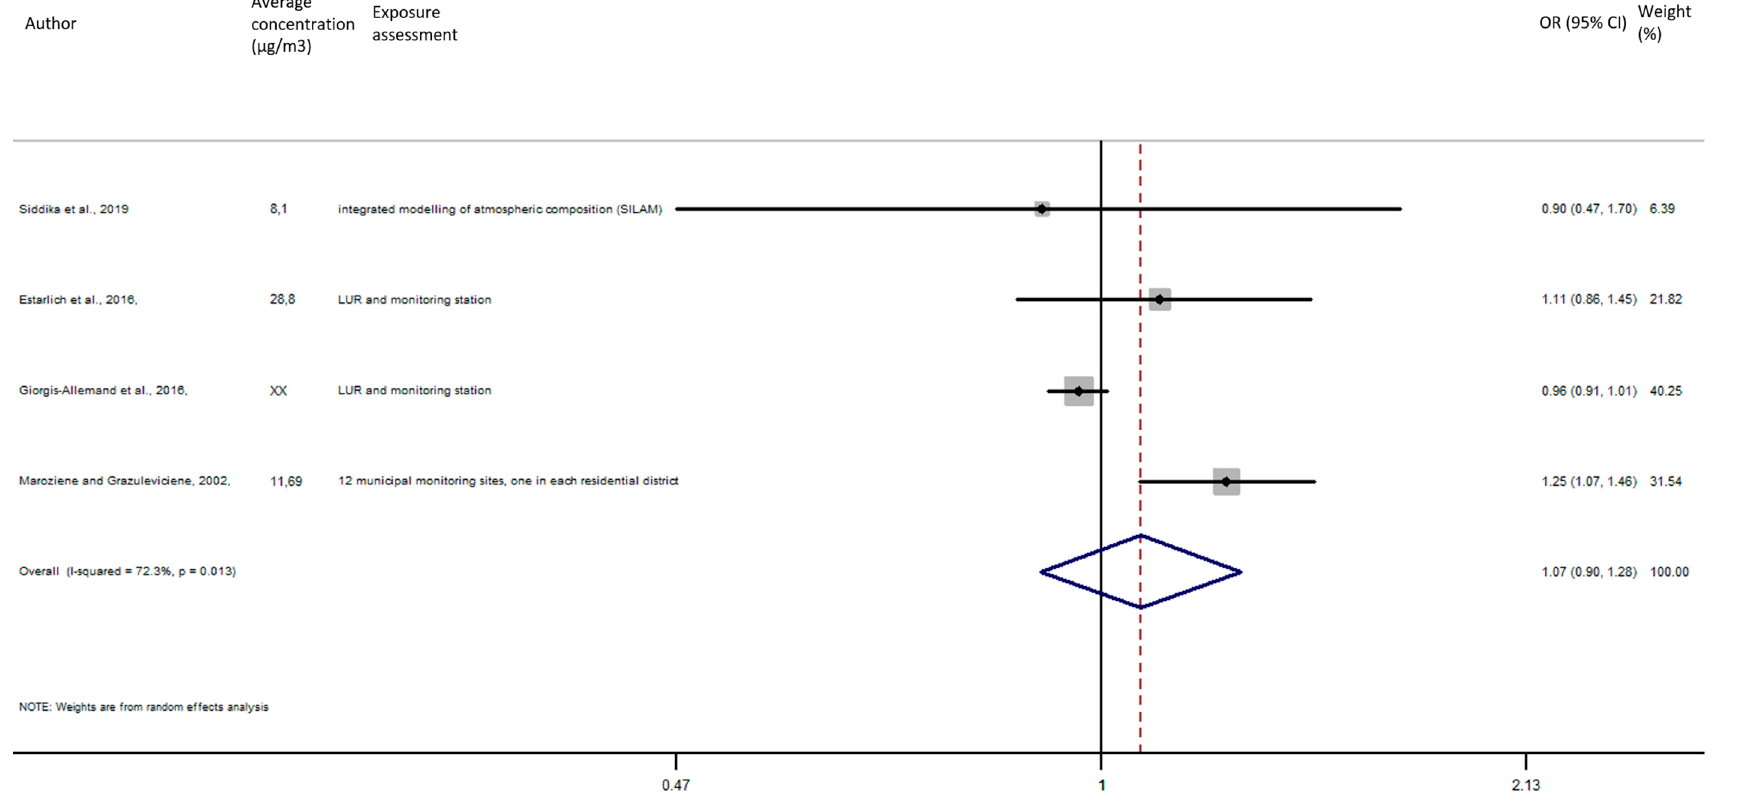
Figure 9. Association between preterm birth and NO 2 exposure during the entire pregnancy.